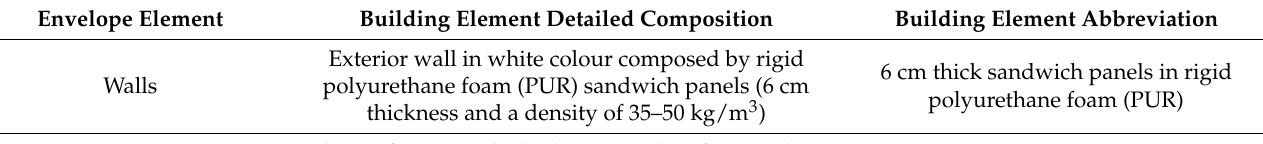
Table 1. Building materials used in the envelope of the case study.